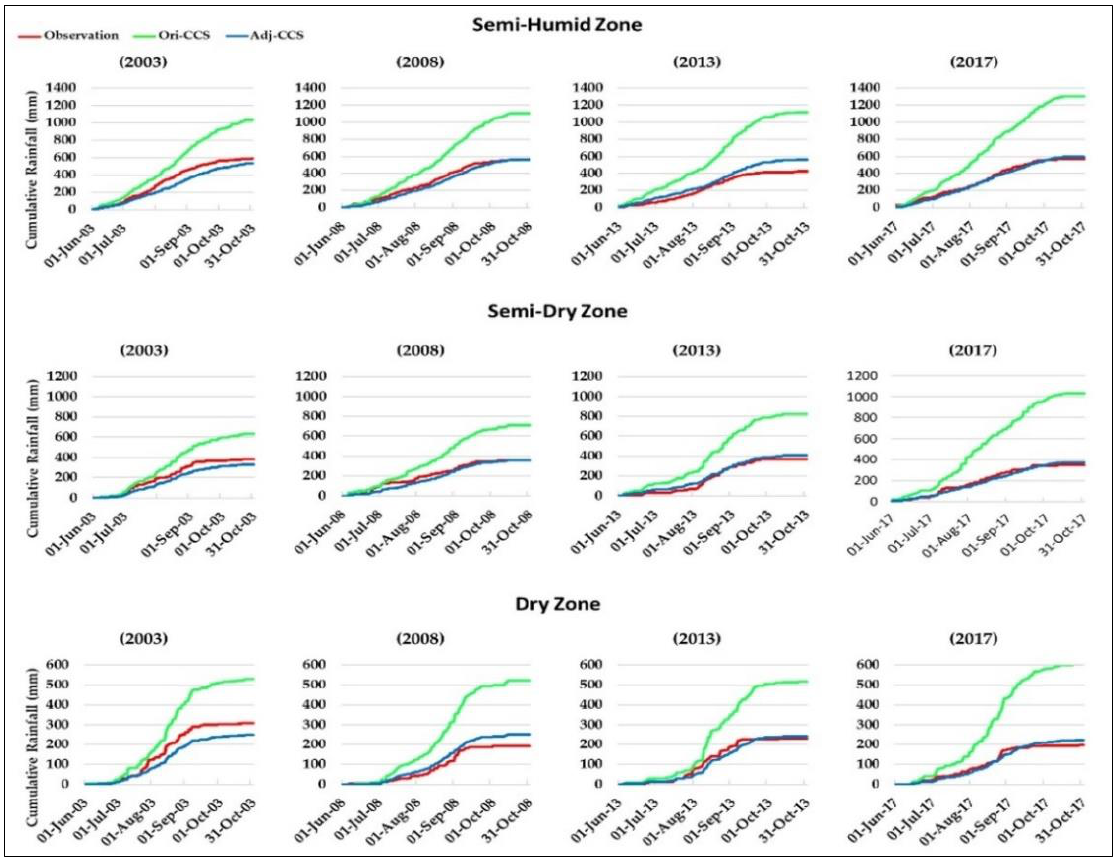
Figure 9. The cumulative rainfall for gauge observations, Ori-CCS, and Adj-CCS. Data from 2003, 2008, and 2013 were used for calibration for the three zones, and 2017 data was used for validation (Figure 10), indicating the accrued daily rainfall time series from the gauge observations, original satellite, and bias-adjusted estimations. Ori-CDR overestimated all CZs during the calibration and validation periods in the selected years. Adjusted rainfall time series were consistent with the overall CZ rainfall time series in all selected years for both periods once the adjustment was made. Thus, the suggested QM method may be used to correct the systematic bias in Ori-CDR rainfall estimates for calibration and validation years over the CZs that were taken into account. Rainfall measurements, satellite estimations, and bias-adjusted estimates for the years 2003, 2008, and 2013 were utilized to represent the calibration period, and 2017 was used for the validation period. Figure 11 shows the accrued daily rainfall time series. Over the semi-humid zone, Ori-CHIRPS was reliable in 2003 and 2017, whereas it was overestimated in 2008 and underestimated in 2013. For the semi-dry zone, Ori-CHIRPS was accurate in 2003, although it was overestimated in 2008 and underestimated in 2013. In contrast, for the dry zone, Ori-CHIRPS was stable in 2003, 2008, and 2013 but was significantly underrated in 2017. For all years except 2003, the Adj-CHIRPS total annual precipitation data were consistent with the gauge measurements over the semi-dry and dry zones after the adjustment. Thus, the suggested QM technique efficiently corrected Ori-CHIRPS rainfall estimates’ systematic bias for calibration and validation years over the considered